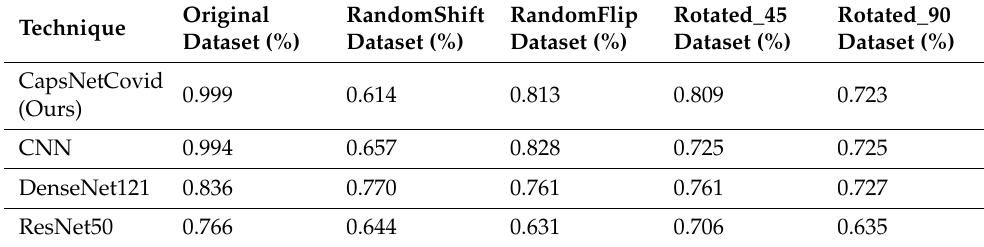
Table 10. ROC score for CT